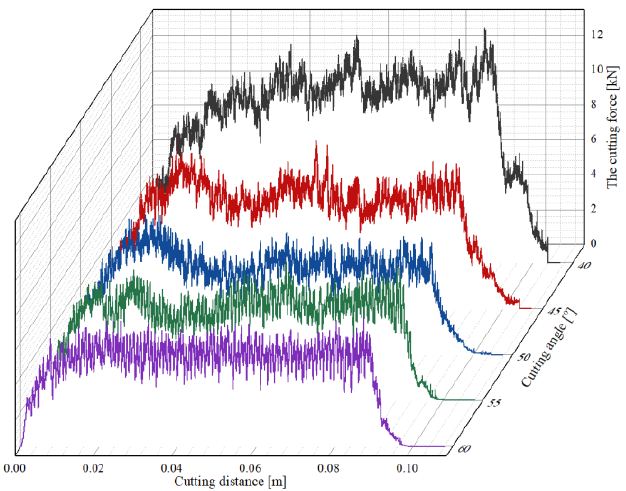
force decreases gradually, the cutting process is stable, and the maximum peak force of the conical pick also decreases gradually. Because the interaction area between the conical pick and rock increases gradually with the cutting angle, the rock breaking volume with various cutting angles is different, resulting in different fluctuations in the conical pick force. Additionally, the cutting angles greatly affect rock damage, and the rock damage cloud with different cutting angles is shown in Figure 10. The volume of rock damage is Figure 10. The rock damage cloud with different cutting angles. Figure 10. The rock damage cloud with different cutting angles. greatly impacted by the cutting angle. The thickness of the rock damage with different cutting angles is basically the same, but the notch size of the rock damage is changed; therefore, as the cutting angle increases, the rock damage decreases. ting angles that the rock damage area is located around the crushing area of the pick.